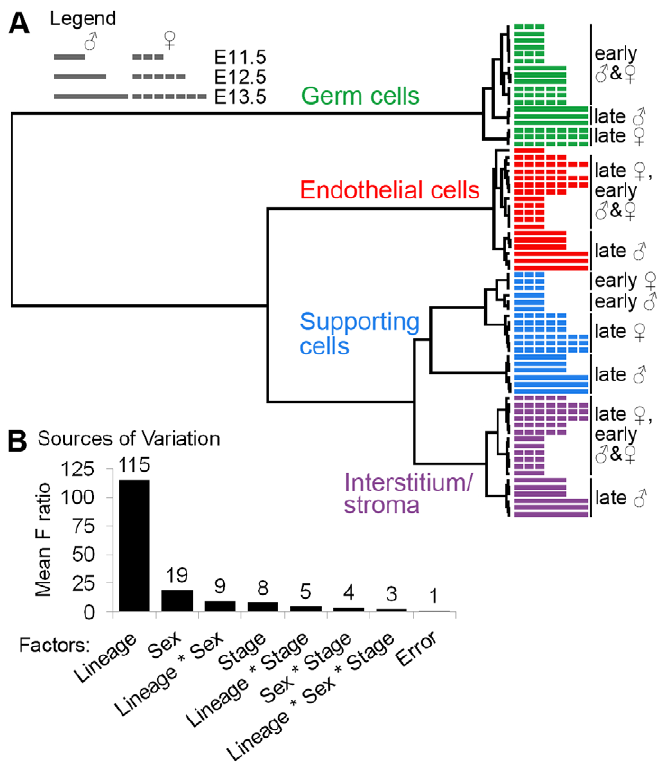
Figure 2. Gene expression was affected by lineage, sex, and stage. (A) Clustering dendrogram of individual microarray samples. The E11.5, E12.5, and E13.5 samples are represented by short, intermediate, and long bars, respectively. The dashed bars indicate XX samples, and the solid bars indicate XY samples. Ward’s method with squared Euclidean distance as the distance metric was used. The arrays cluster primarily by lineage, and secondarily by sex and stage. (B) Analysis of the sources of variation confirmed that the primary source of variation is lineage, and secondarily sex and stage.